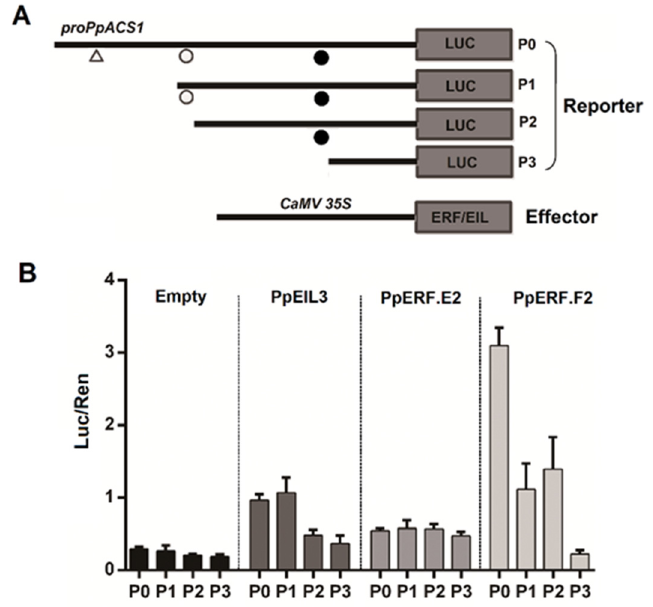
Figure 7. Promoter deletion analysis of PpACS1 . ( A ) Four promoter deletion constructs used for the construction of reporter cassette and ERF / EIL genes related to the e ff ector cassette. The predicted DRE, PERE-like, and PER motifs are indicated by a triangle, white circle, and black circle, respectively. ( B ) Assay of the activation e ff ect of PpEIL3, PpERF.E2, and PpERF.F2 on four di ff erent length sequences of PpACS1 using the dual luciferase assay. The error bars show SE of four biological replicates.